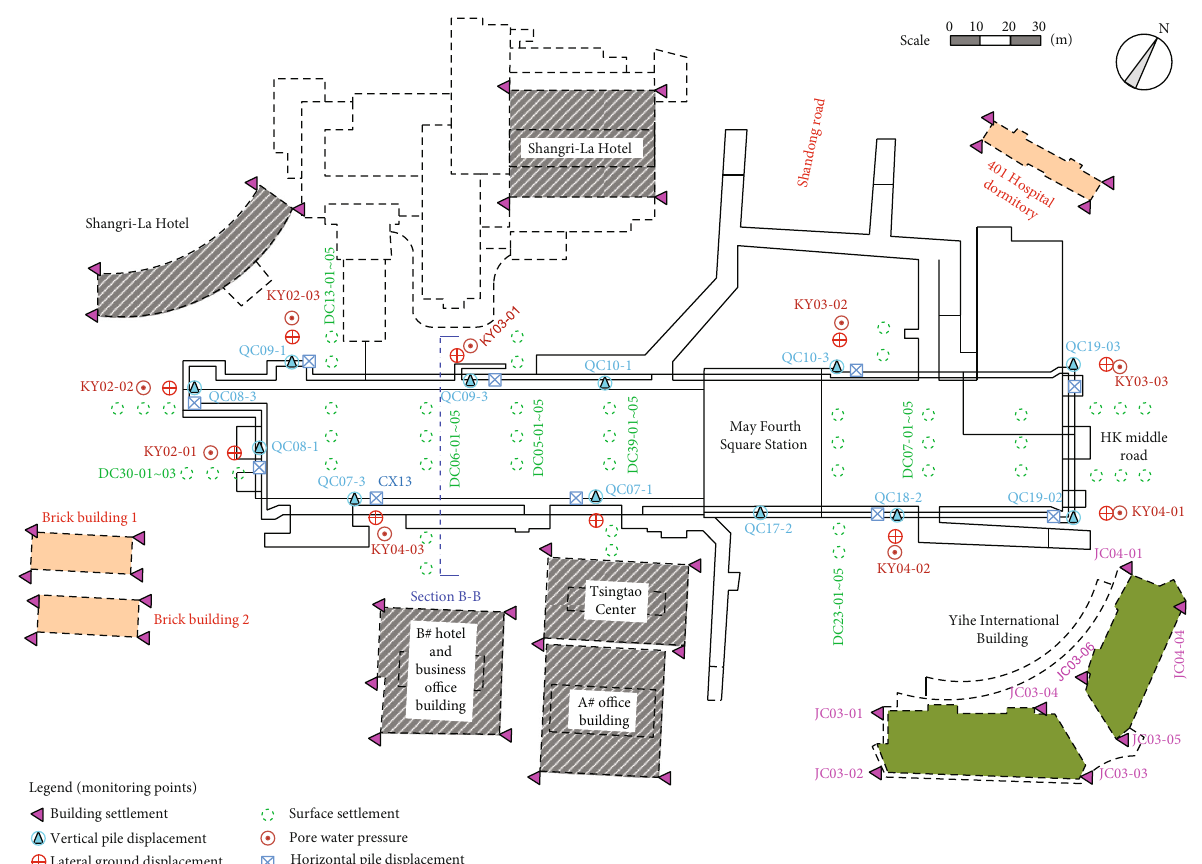
Figure 1: Plan view of the May Fourth Square Station excavation case